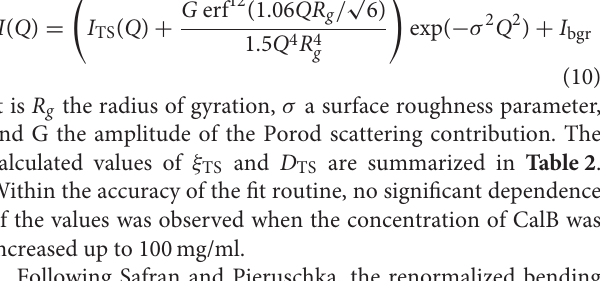
FIGURE 3 | Semi-logarithmic representation of the normalized intermediate scattering functions S ( Q , τ NSE ) / S ( Q ,0) obtained at momentum transfer values Q 0.08, 0.12, 0.15, 0.18, 0.21, and 0.24Å -1 (from top to bottom). A bicontinuous microemulsion in film contrast with four enzyme concentrations of 0 mg/ml (A) ,